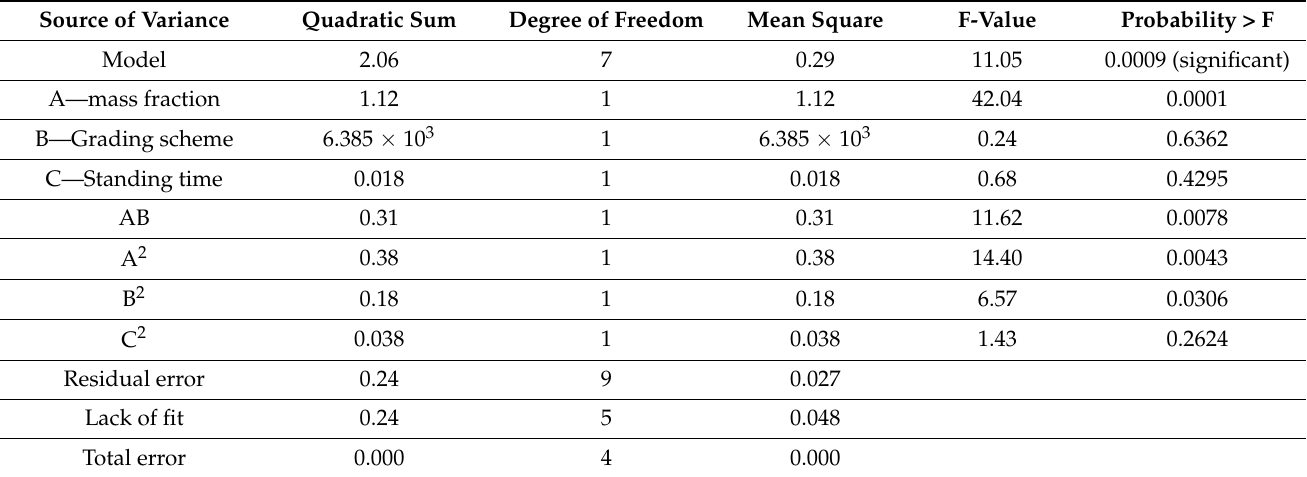
Table 14. Variance analysis results of response surface analysis and fitting regression